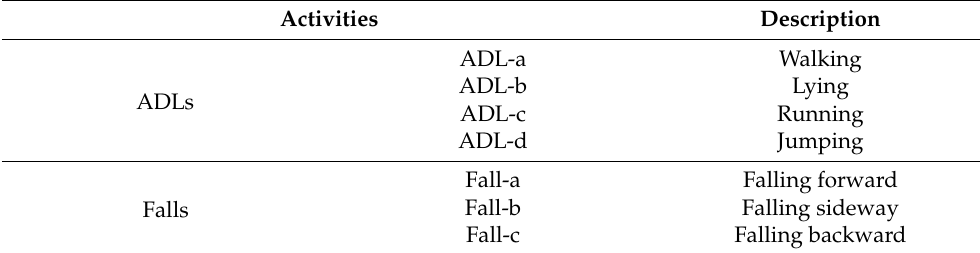
Table 1. Description of four types of ADL and three types of